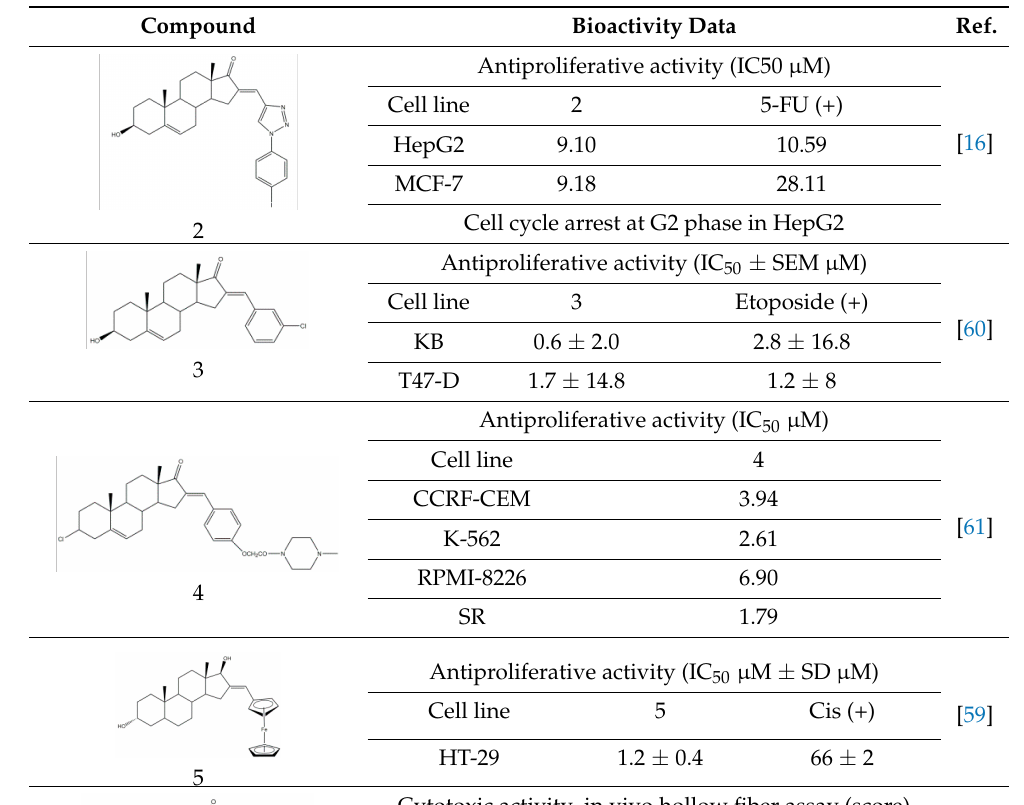
Table 1. Examples of relevant bioactive 2- and 16 E -arylideneandrostane derivatives. Positive controls, when shown, are identified by (+)